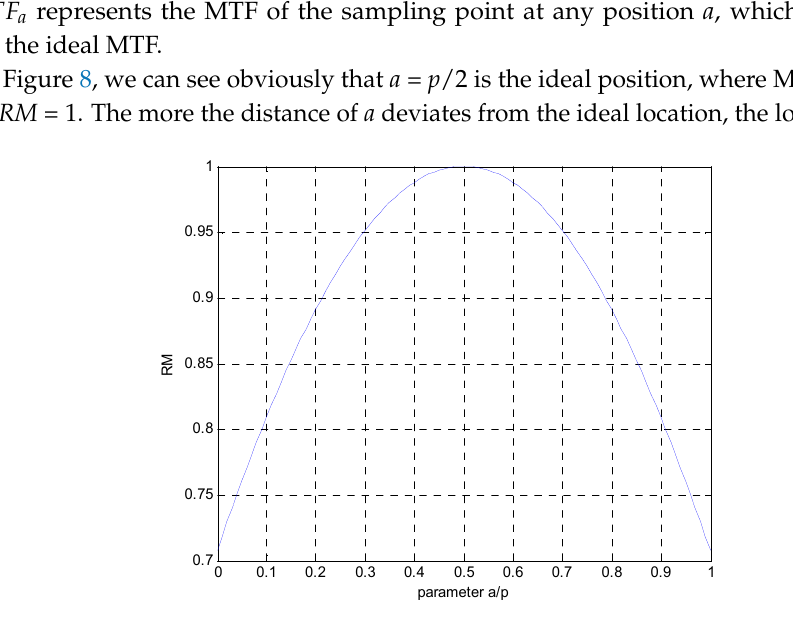
Figure 8. Relation diagram between RM and sampling point location.